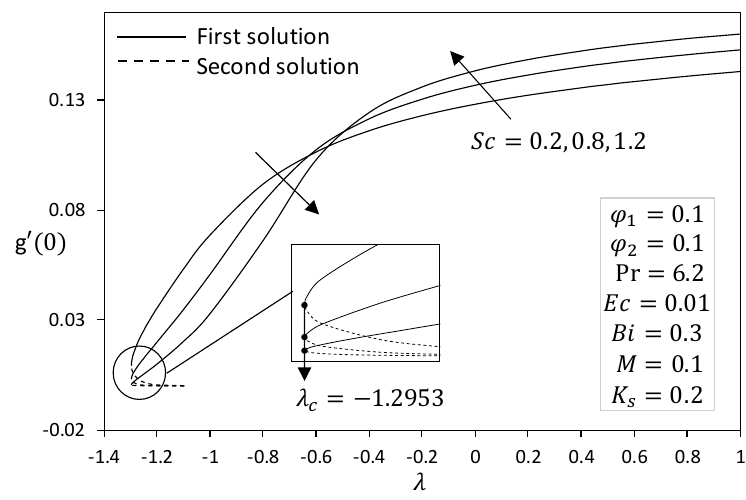
Figure 6. Concentration for several values of Sc .